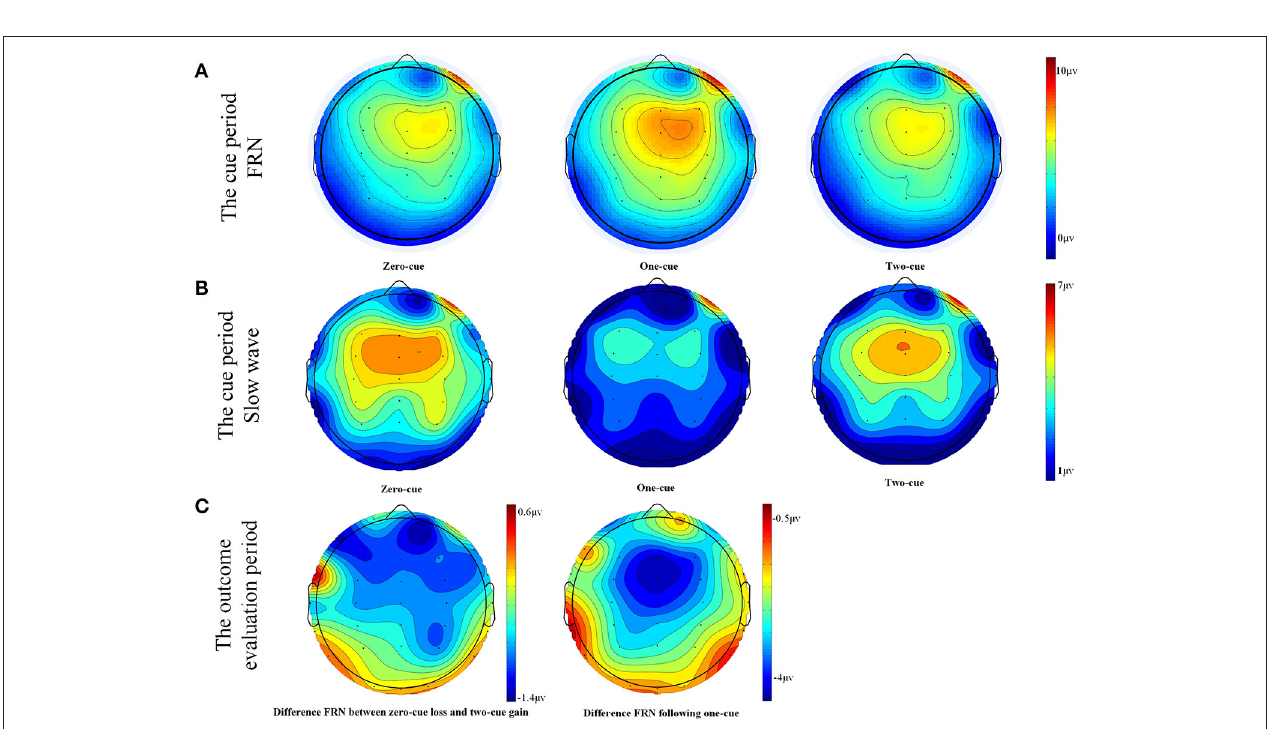
FIGURE 2 | (A) Scalp topographies for each condition in the time window of 200–300 ms during the cue period. (B) Scalp topographies for each condition in the time window of 800–1000 ms during the cue period. (C) Scalp topographies for differences in waves during the time window of 280–380 ms in the outcome evaluation